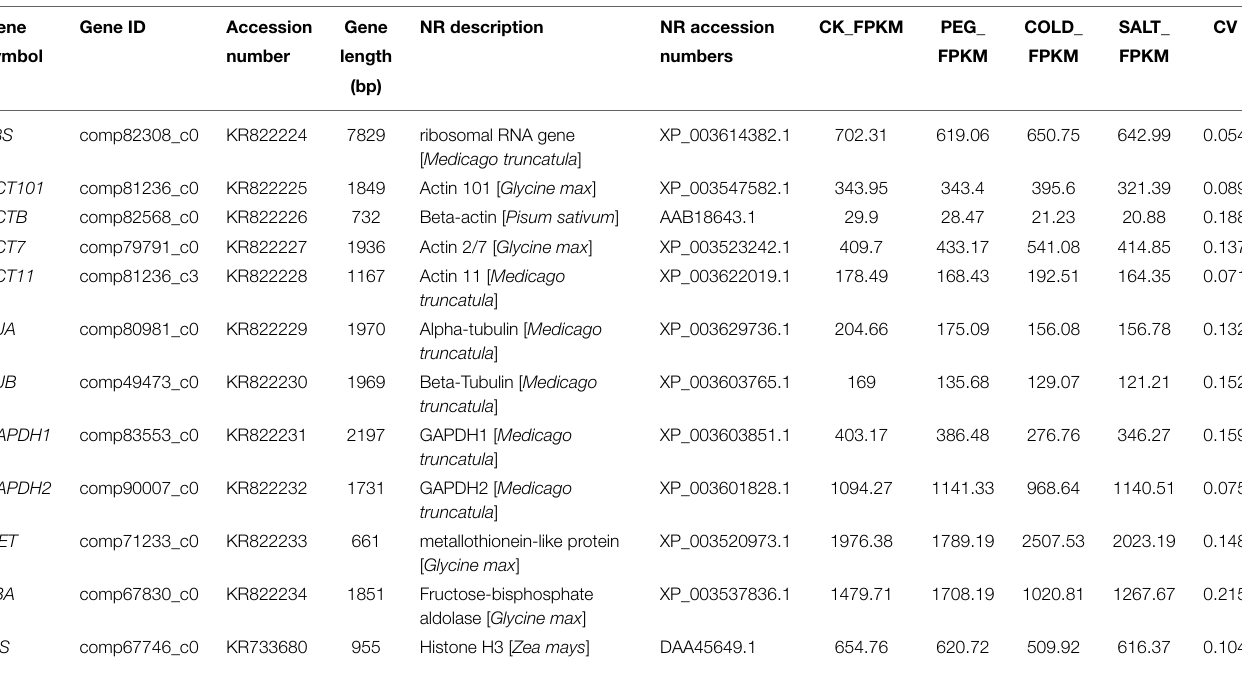
TABLE 1 | Description of the candidate reference genes in transcriptome datasets of O.